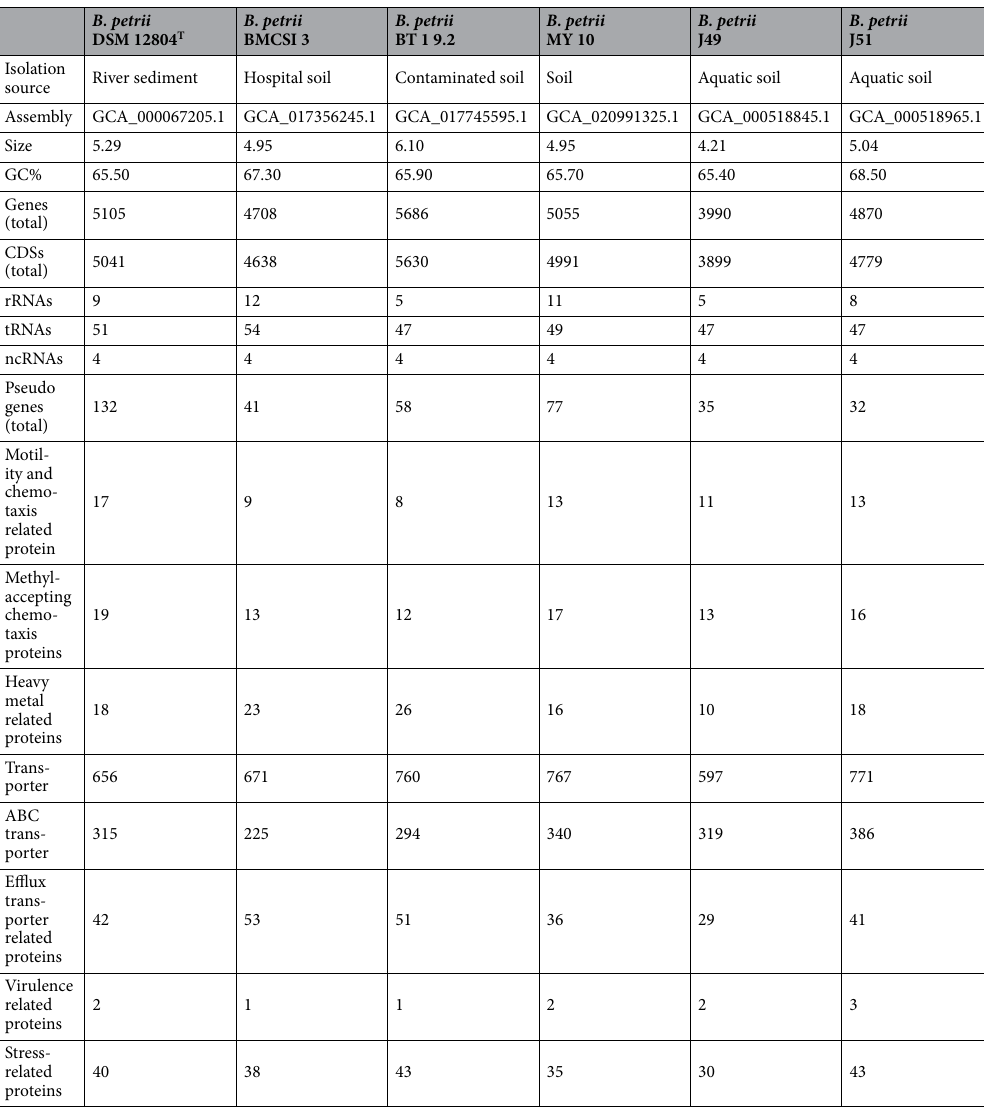
Table 1. NCBI PGAP annotated genome features comparison between all available strains of B. petrii